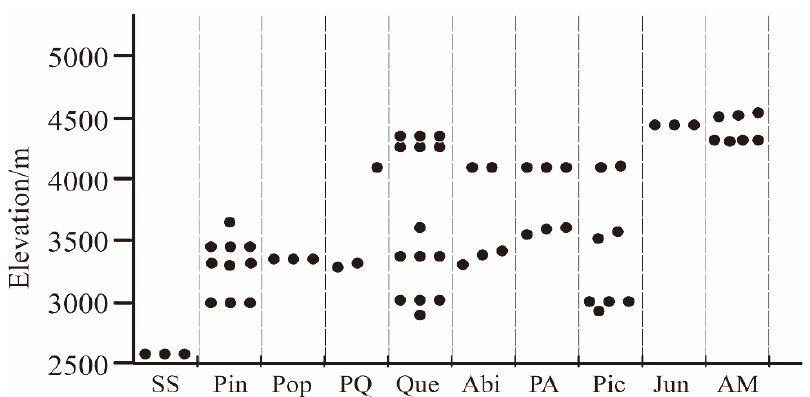
Figure 2. Sample plots distribution and elevation. The horizontal axis is the vegetation type, arranged from left to right according to the average elevation from low to high.